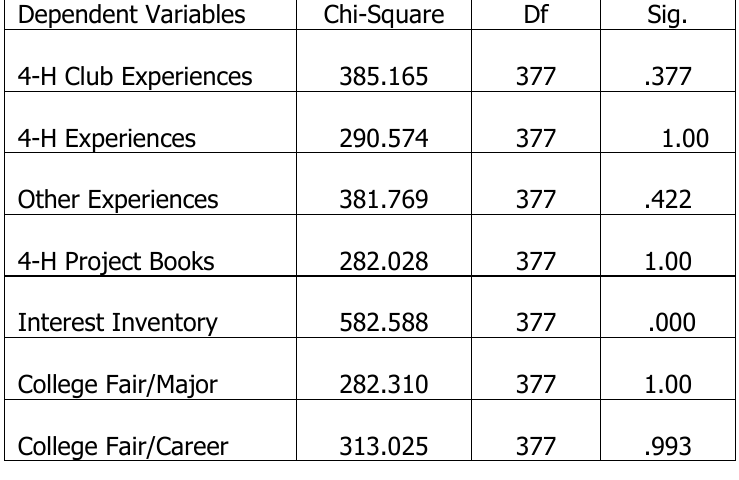
Pearson Goodness of Fit Statistic for Dependent Variables Dependent